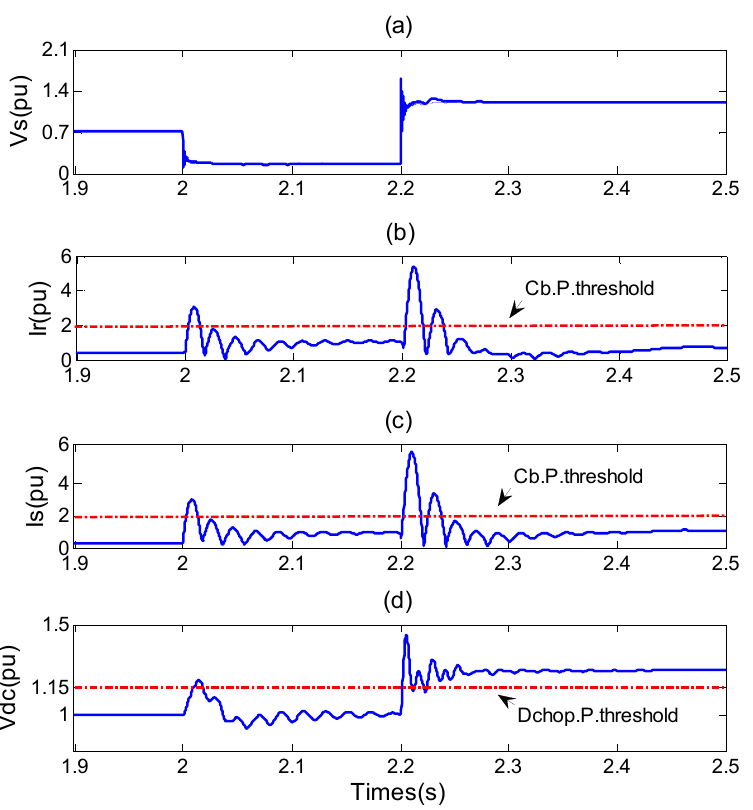
Figure 11. The responses of the DFIG WTG for case 1: ( a ) stator voltage; ( b ) rotor current; ( c ) stator current; and ( d ) DC